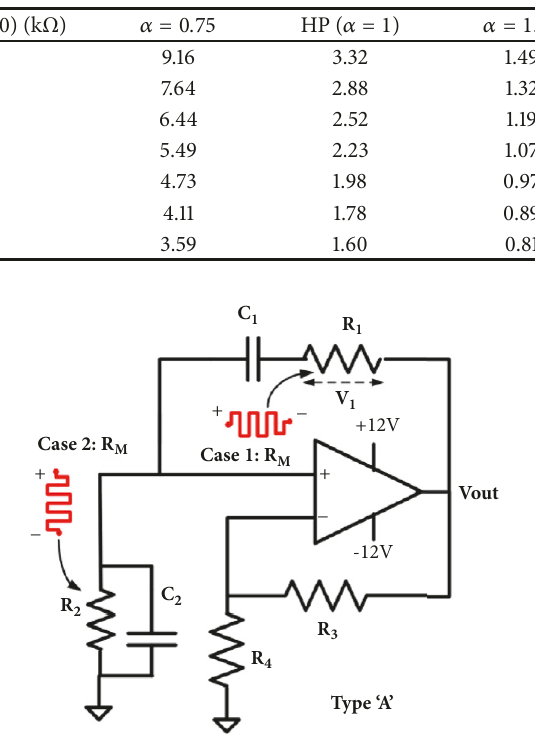
Figure 24: The memristor based Wien oscillator